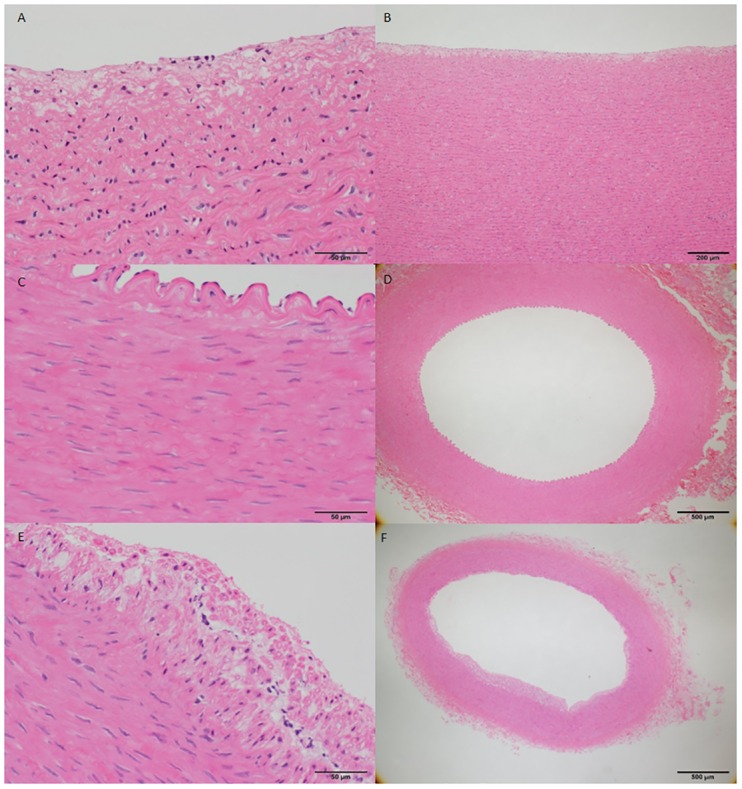
(A-F): Histological features of non-injured vessels of 12 week model.A and B, ascending aorta; C and D, carotid artery; E and F, right coronary artery). Intimal thickening with extracellular lipid accumulation in the luminal part of an arterial intima. Scale bar, 50 μm on the left panel and 200–500 um on the right panel.